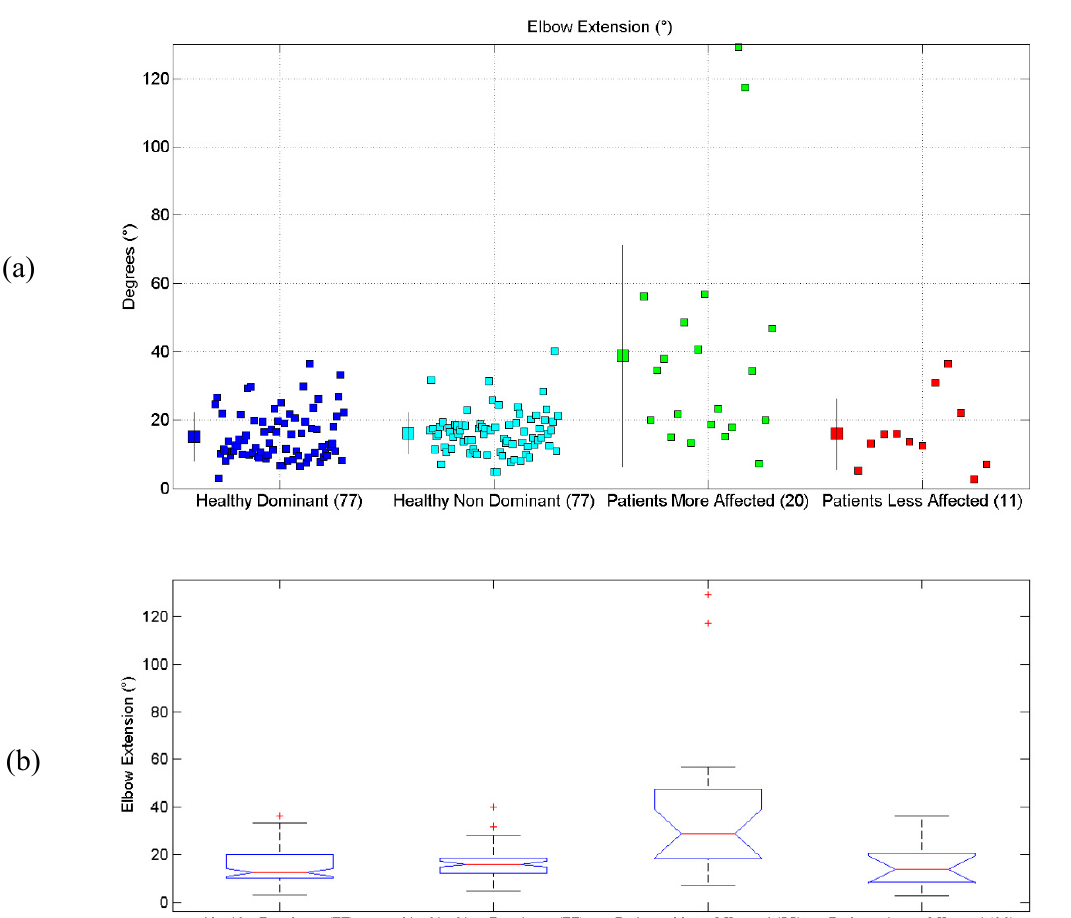
Figure 6. ( a ) Scatterplot for Elbow Extension Angle for the four considered groups. Mean (SD) of each population (considered limb) are reported. ( b ) Distributions of Elbow Extension Angle, are shown for the four experimental conditions. The central line indicates the median, while the lower and upper extremities of the boxes represent the 25th and 75th percentiles, respectively. The whiskers comprise all the data points distribution except the outliers, which are plotted separately using the ‘+’ mark.